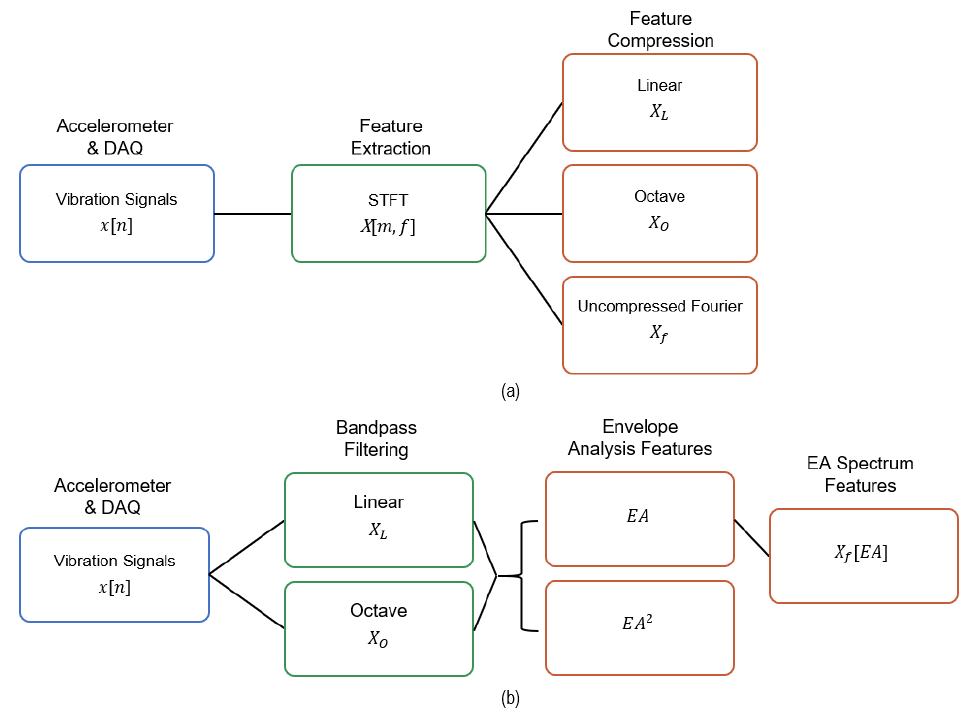
Figure 4. ( a ) STFT feature extraction approach with feature compression and ( b ) the three feature extraction approaches investigated for Envelope Analysis